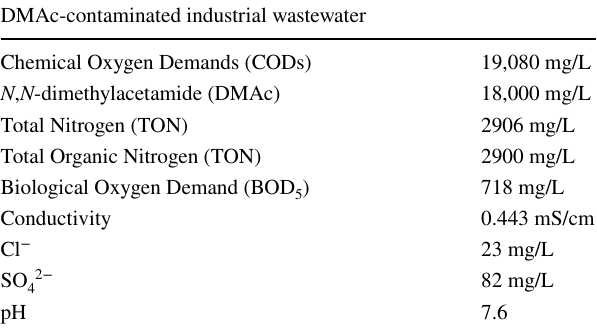
Table 1 The wastewater from polymeric membrane manufacturer DMAc-contaminated industrial wastewater